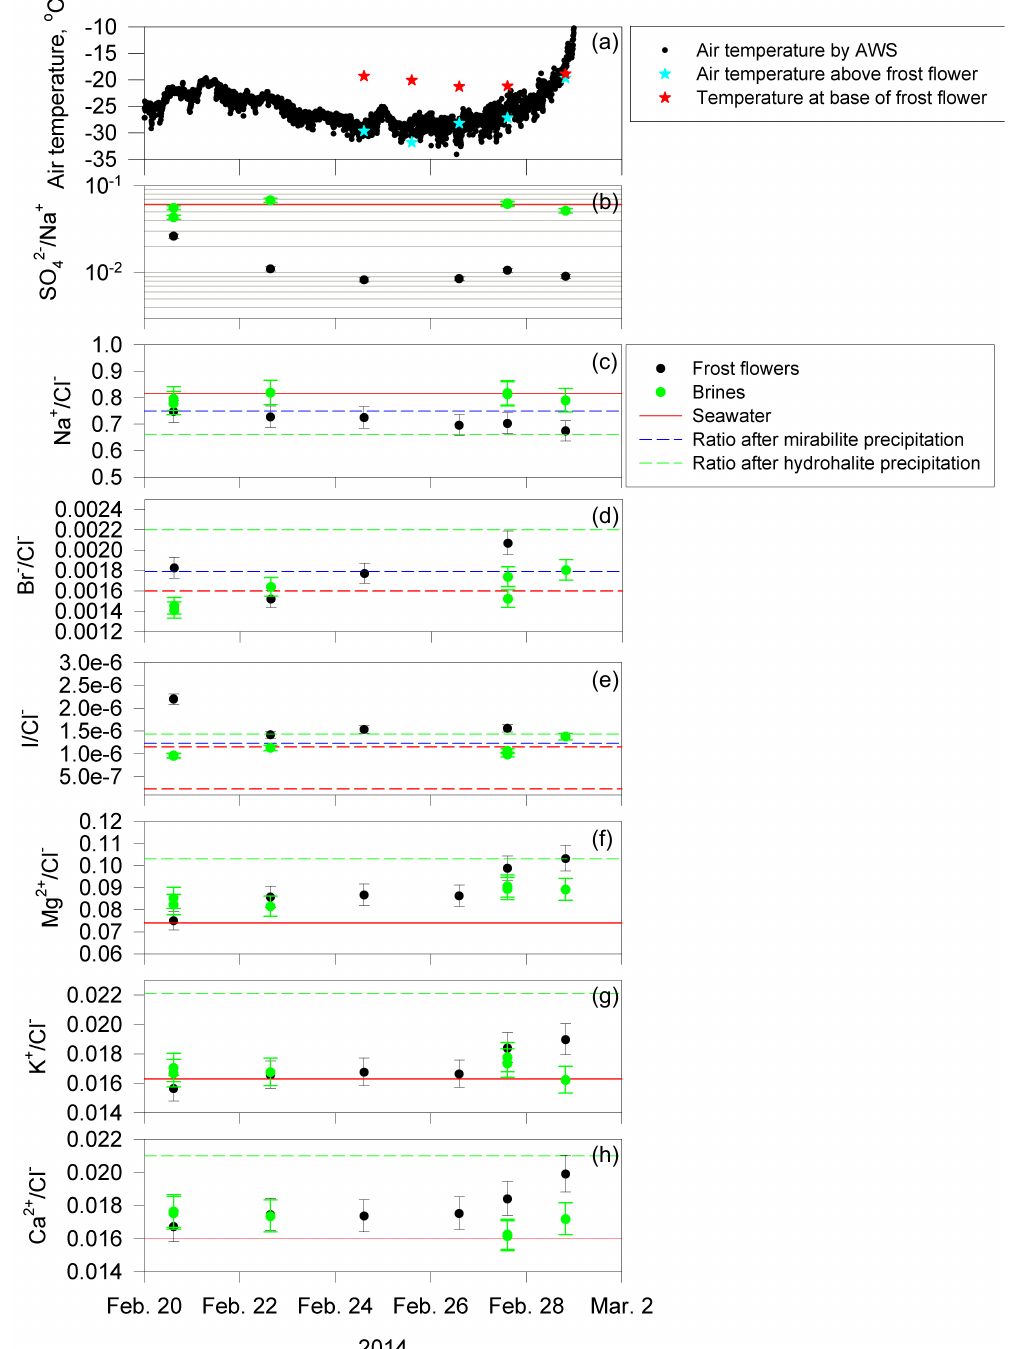
Figure 6. Short-term features of (a) air temperature measured by AWS ( T AWS ) , air temperature above frost flowers ( T air , ca. 10cm above the sea-ice surface), temperature of base of frost flowers ( T FF ) , and (b–h) molar ratios of sea salts in frost flowers and brine at site I. T air and T FF were not measured on 20–22 February. Error bars indicate standard deviation (1 σ) of analytical errors. Blue and green dashed lines show the molar ratios after precipitation of mirabilite and hydrohalite,